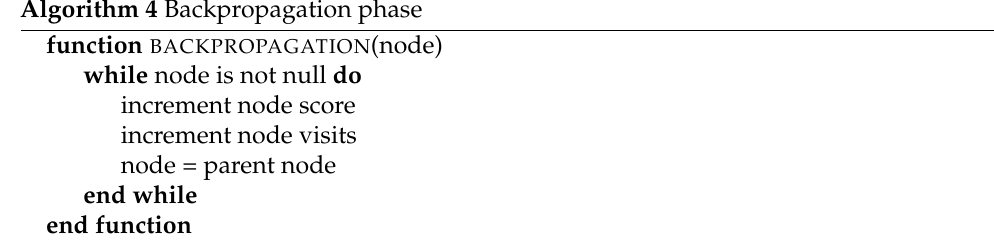
Algorithm 4 Backpropagation